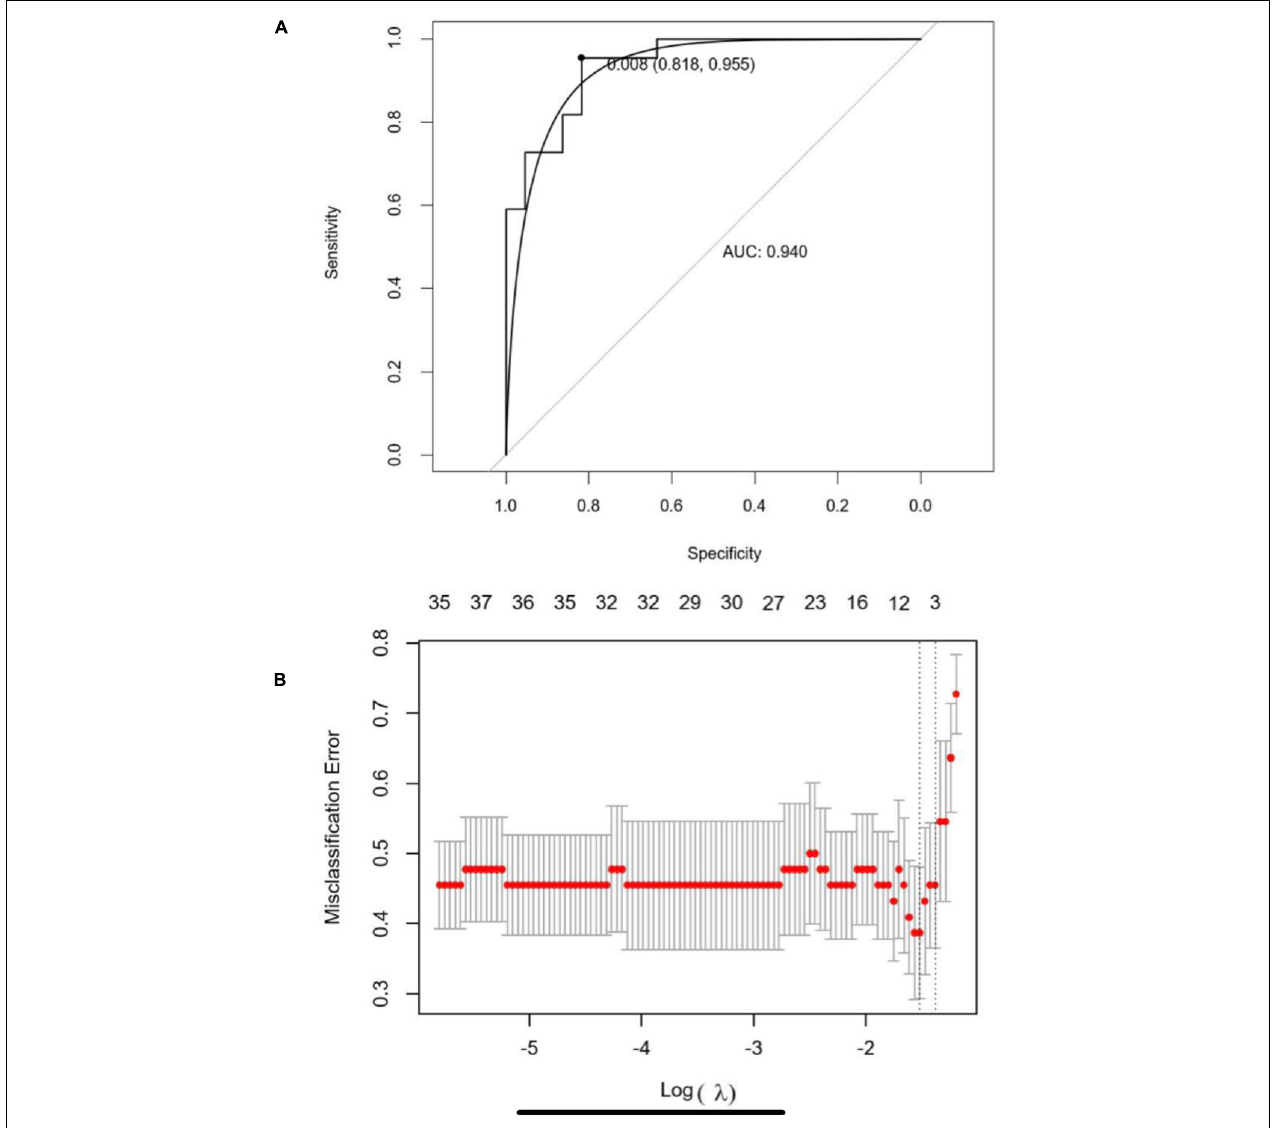
FIGURE 5 | (A) Five-fold cross-validation for tuning parameter ( λ ) selection in the LASSO regression model. The partial likelihood deviance is plotted in log( λ ), in which vertical lines are shown at the optimal values by minimum criteria and 1-SE criteria. (B) Receiver operating characteristic curve (ROC) of the LASSO-binary logistic regression